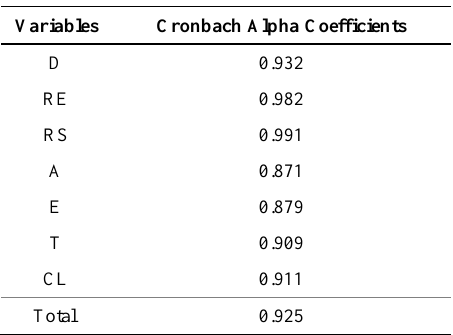
Table 3. Instrument